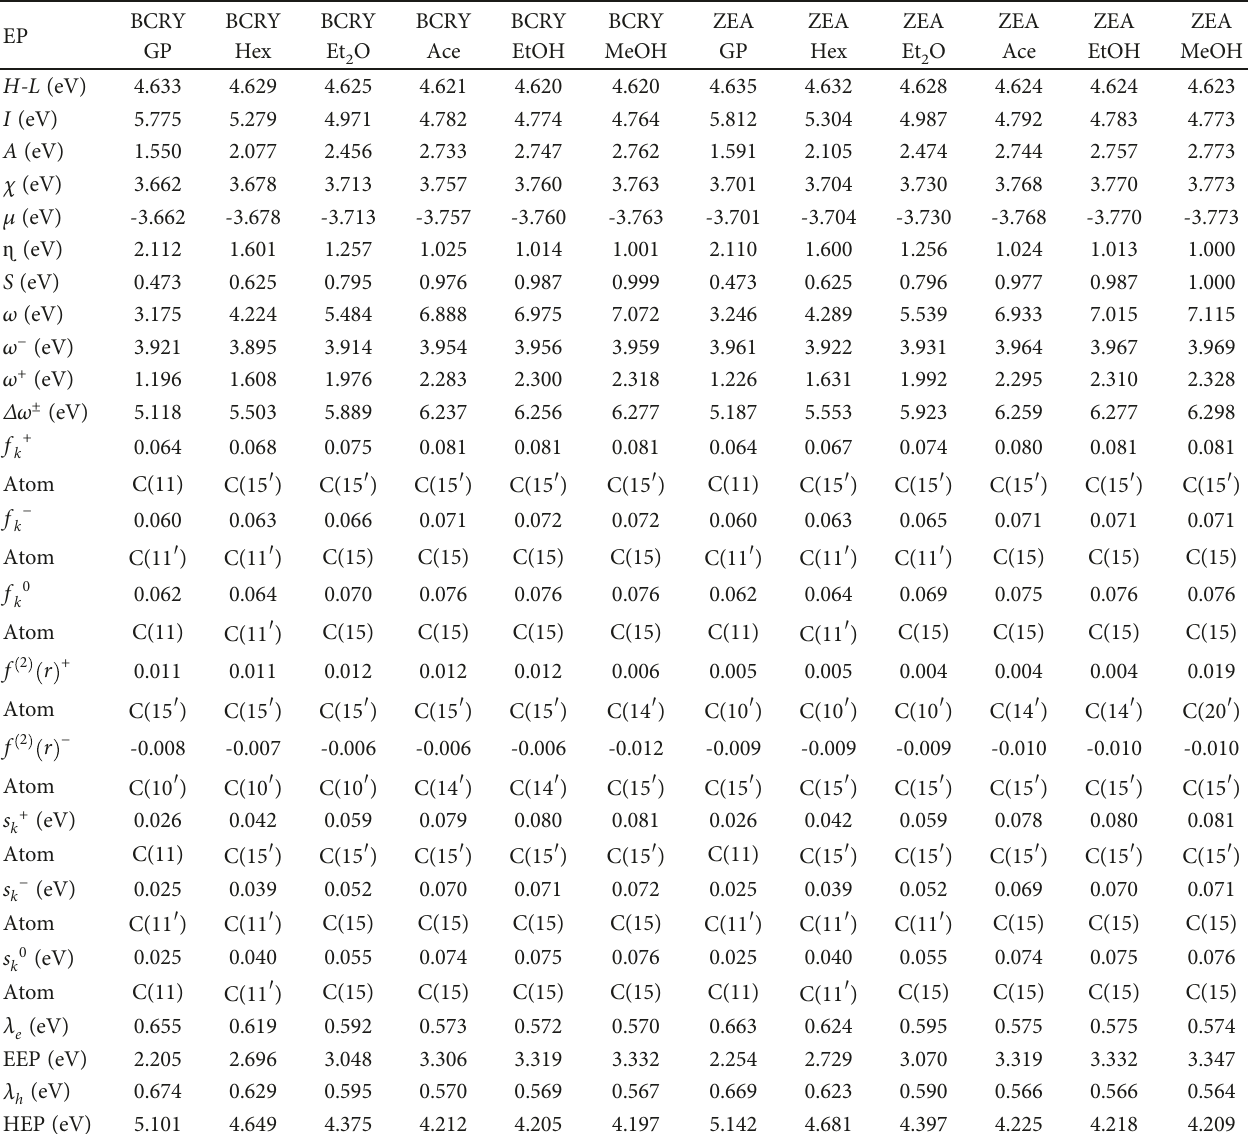
Table 4: Electronic properties of BCRY and ZEA in GP, Hex, Et are